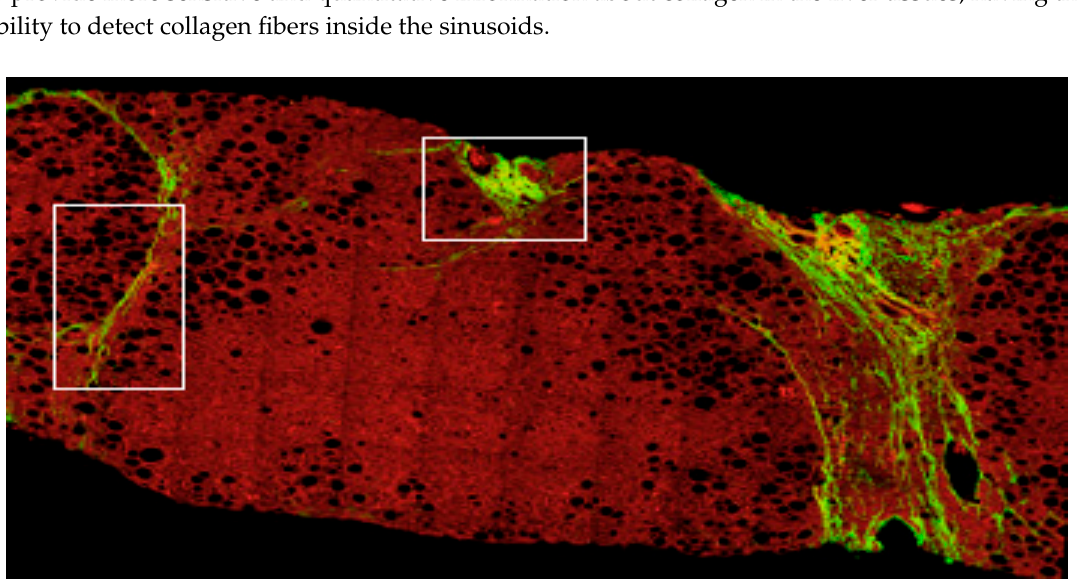
Figure 7. Localization of 2D collagen patterns in second-harmonic generation / two-photon excitation fluorescence (SHG / TPEF) microscopy imaging. The TPEF image provides red color values for the scanned tissue sample, while SGH signals indicate the areas of collagen deposition in green.